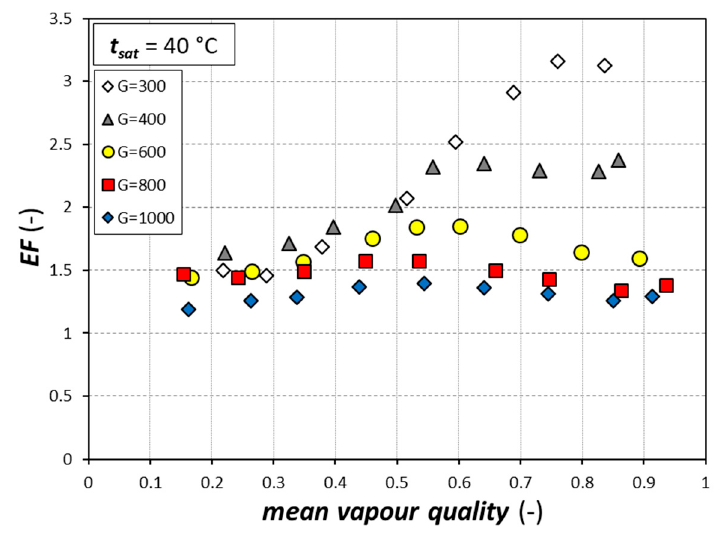
Figure 8. Enhancement Factor (EF) vs. mean vapor quality at t sat = 40 °C. G expressed in [kg m − 2 s − 1 ].